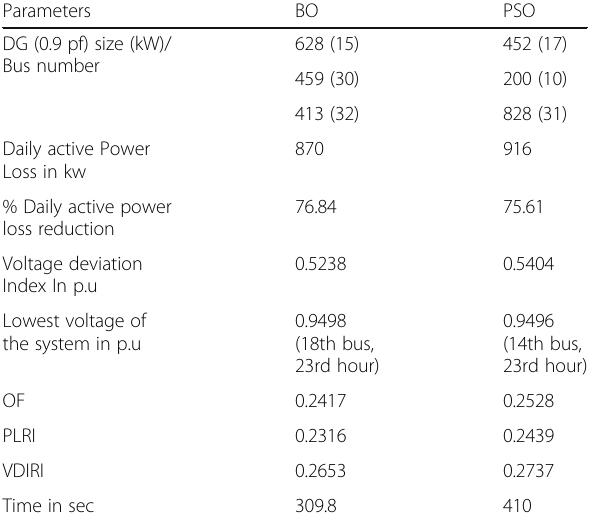
Table 5 Result analysis for optimal allocation of DGs at 0.9 pf Parameters